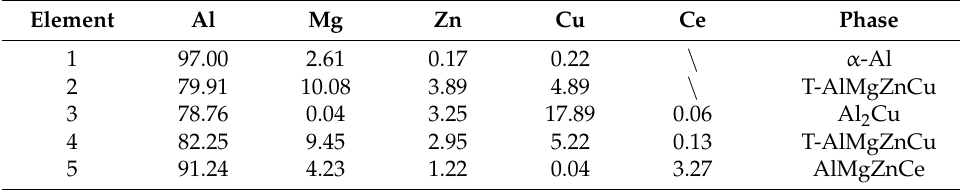
Figure 3. SEM diagram of Al-5Mg-3Zn-1Cu alloy with different Ce content: ( a ) 0.0 Ce wt.%, ( b ) 0.25 Ce wt.%. ( b ) 0.25 Ce wt.%. Table 3. EDS point scanning element content (element content,